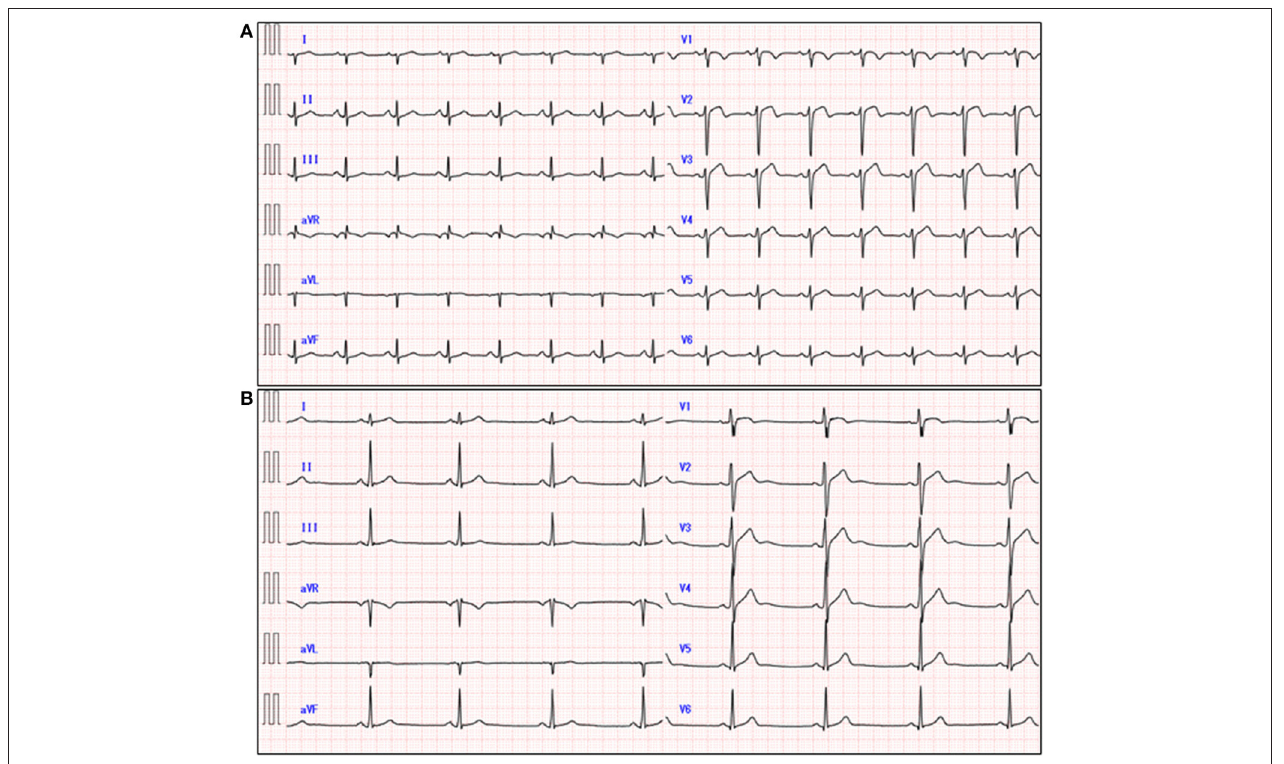
FIGURE 1 | Electrocardiogram at admission (A) and on day 11 (B)